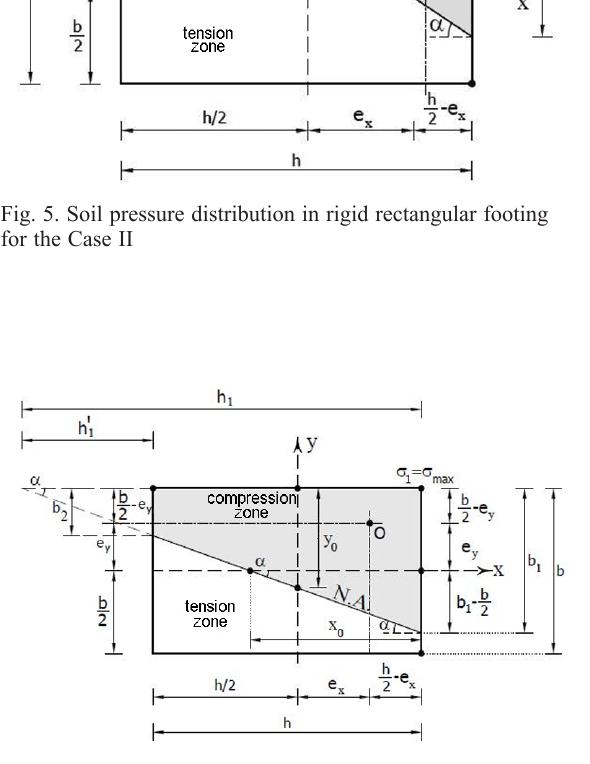
Fig. 6. Soil pressure distribution in rigid rectangular footing for the Case III